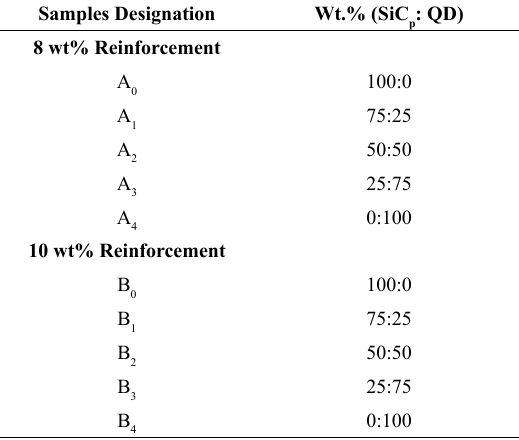
Table 1. Samples Designation for the produced ZA-27 Composites Samples Designation